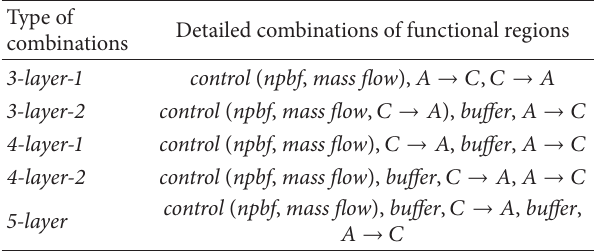
Table 3: Details of different combinations of functional regions to be compared